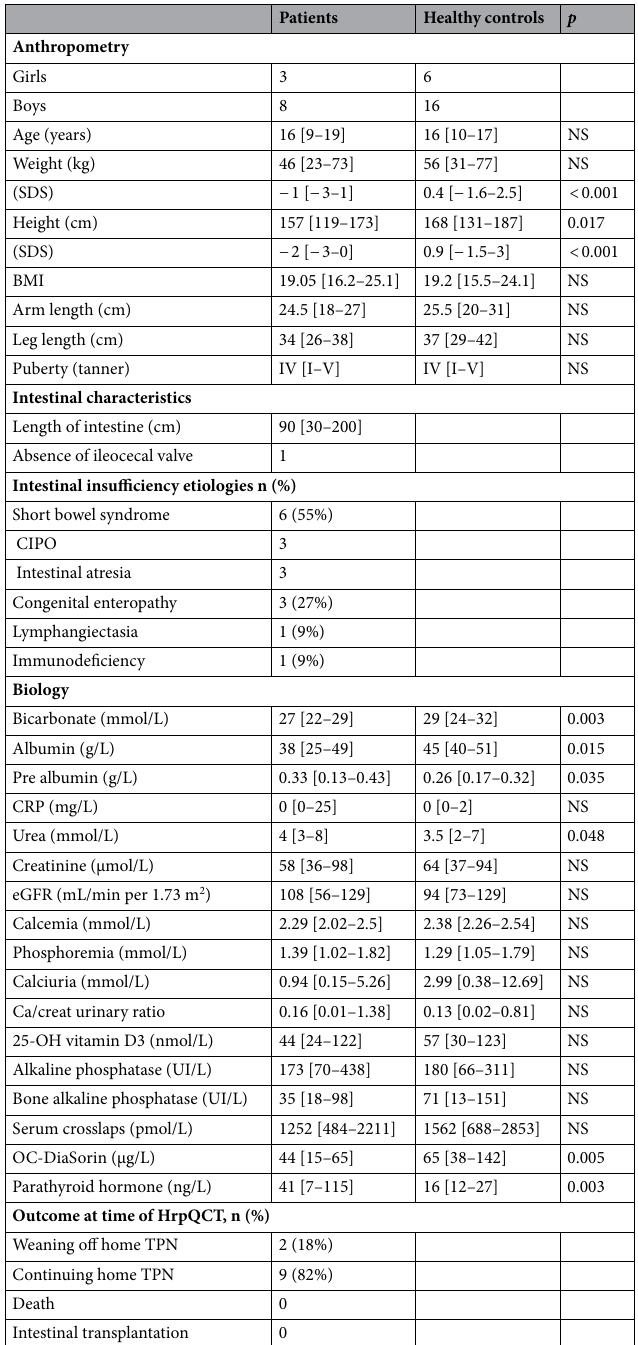
Table 1. Characteristics of patients and controls. Results as median [min–max], CIPO Chronical intestinal pseudo obstruction, Creatinine clearance according to new Schwartz equation (0.413*(height/serum creatinin), CRP: C reactive protein, OC: osteocalcin; SDS: Standard deviation, using national reference growth charts, TPN: Total Parenteral